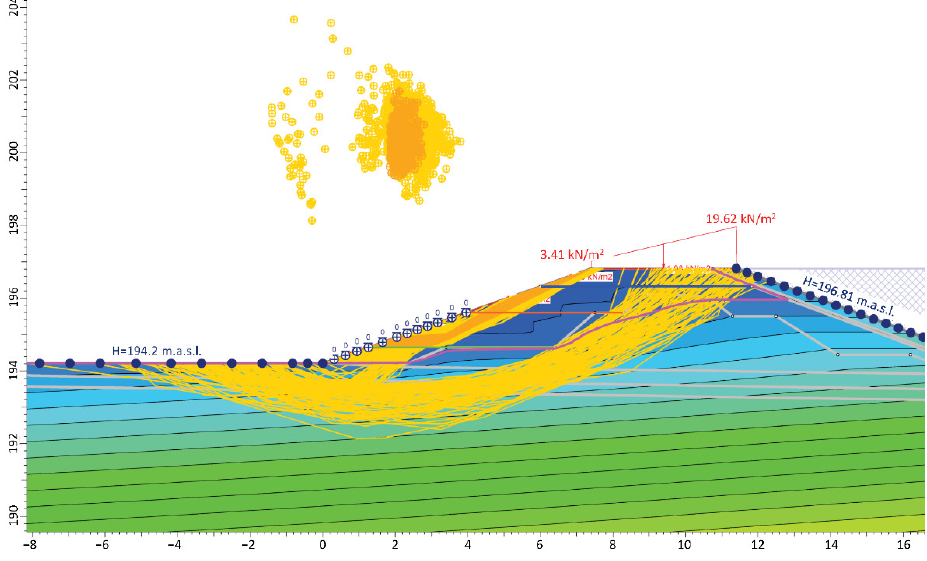
Figure 7. Shallow and deep surfaces on a characteristic slope stability analysis.